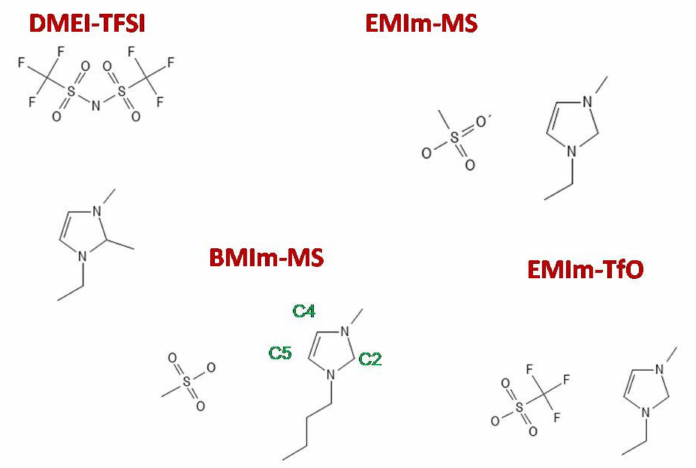
Figure 1. Scheme of the cation and anion composing the investigated ionic liquids with labels of the C atoms of the imidazolium